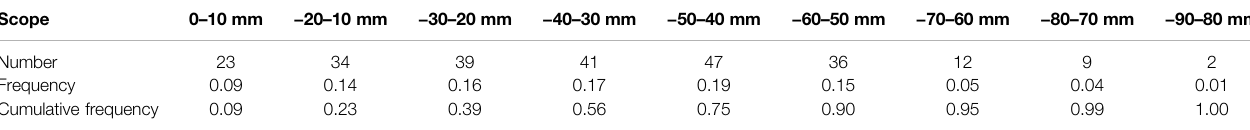
TABLE 8 | Statistics of surface settlement